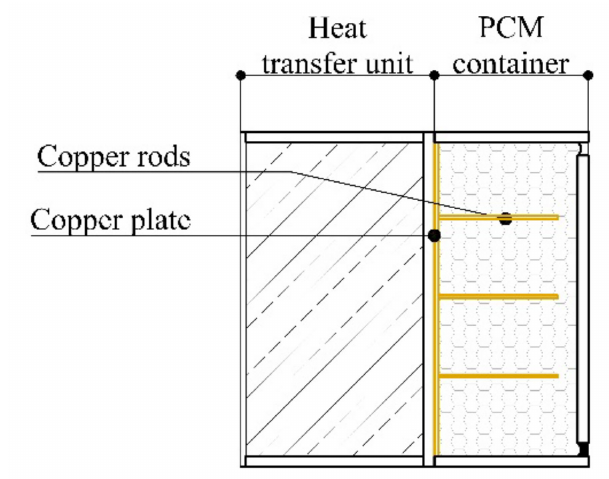
Figure 1. Conceptual design of a solar facade module consisting of a PCM container and heat transfer